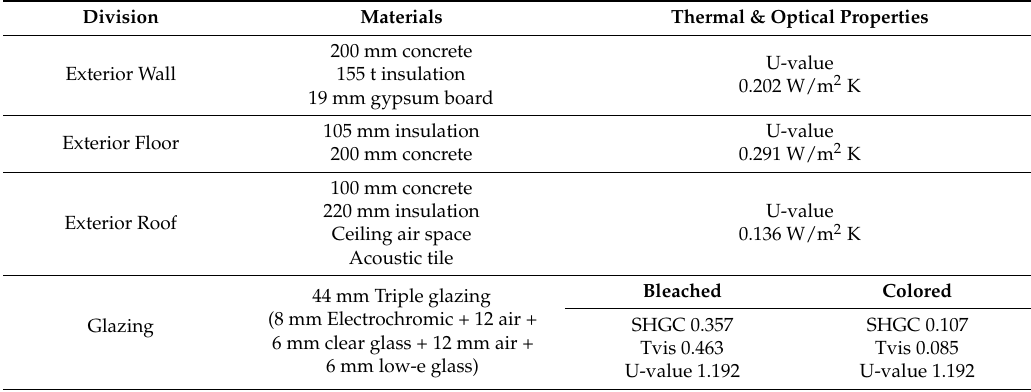
Table 2. Composition of the simulation base model 1